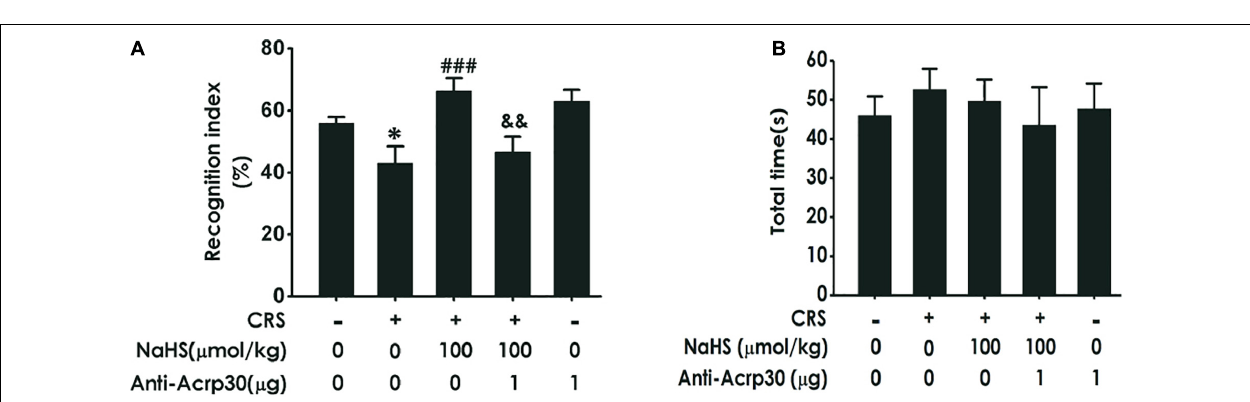
FIGURE 2 | Effects of Anti-Acrp30 on NaHS-resulted in the improvement of CRS-induced cognitive impairment in Y-maze test. Rats were cotreated with NaHS (100 µ mol/kg/day, i.p.) and CRS (6 h/day) for 3 weeks, and then co-administrated with Anti-Acrp30 (1 µ g/day, i.c.v.) for further 1 week. The spatial working memory function of rat was detected by the Y-maze test and the alternation performance (A) and the total arm entries (B) were respectively recorded. All values are expressed as mean ± SEM ( n = 8–10/group). * P < 0.05, vs. control group; ## P < 0.01, vs. CRS-exposed alone group; && P < 0.01, vs. cotreatment with NaHS and CRS group. CRS: chronic restrain stress.